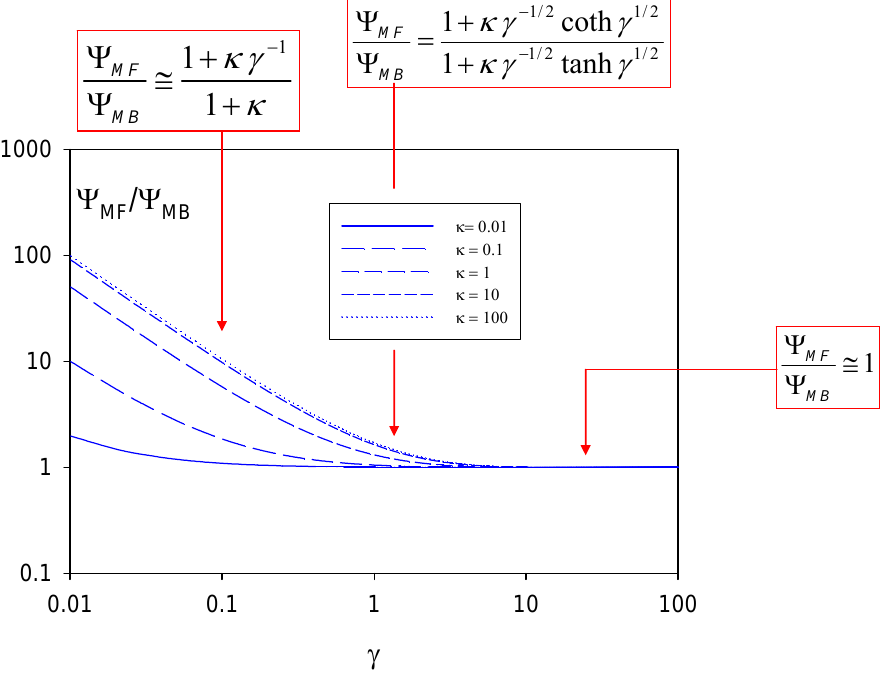
Figure 10. The ratio of the amperometric response obtained for the membrane free configuration to that corresponding to the membrane bound situation as a function of the normalized parameter γ which compares the rate of enzyme diffusion in the solution region next to the detector electrode with the rate describing the reaction between enzyme and substrate in the solution. The flux ratio is presented also for various values of the parameter κ which compares the rate of the reduced enzyme reaction at the detector electrode surface to that of reduced enzyme diffusion to the electrode